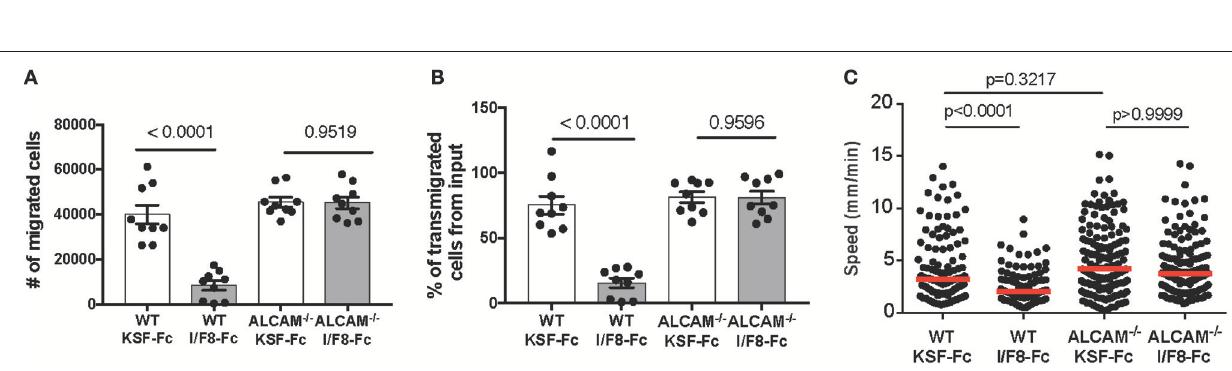
FIGURE 4 | ALCAM blockade reduces DC transmigration and crawling on lymphatic endothelium in vitro. (A,B) imLECs were seeded on the lower surface of transwell inserts and grown to confluence. Transmigration of BM-derived WT or ALCAM – / – BM-DCs across imLEC monolayers was investigated in presence of either KSF-Fc (control) or I/F8-Fc antibody. (A) Absolute numbers and (B) % of transmigrated DCs from the input. Each dot represents the value obtained from one transwell. Pooled data from 3 similar experiments (involving 3 transwells per condition per experiment) are shown in (A,B) . (C) DCs isolated from either WT or ALCAM − / − mice were treated with I/F8-Fc or KSF-Fc antibody, followed by analysis of crawling speed on ALCAM-expressing imLEC monolayers. Each dot represents one DC. Pooled data from 2 to 3 similar experiments are shown. KSF-Fc: control antibody. I/F8-Fc: anti-ALCAM.